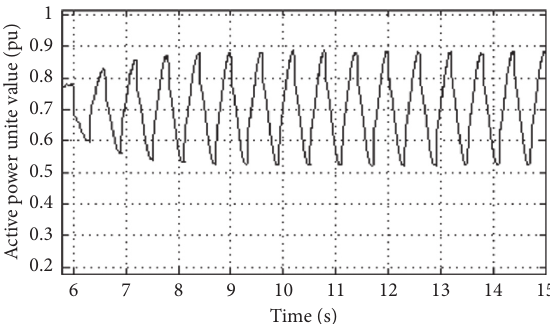
Figure 15: The active power oscillation curve of line under small-scale load attack with a disturbance frequency of